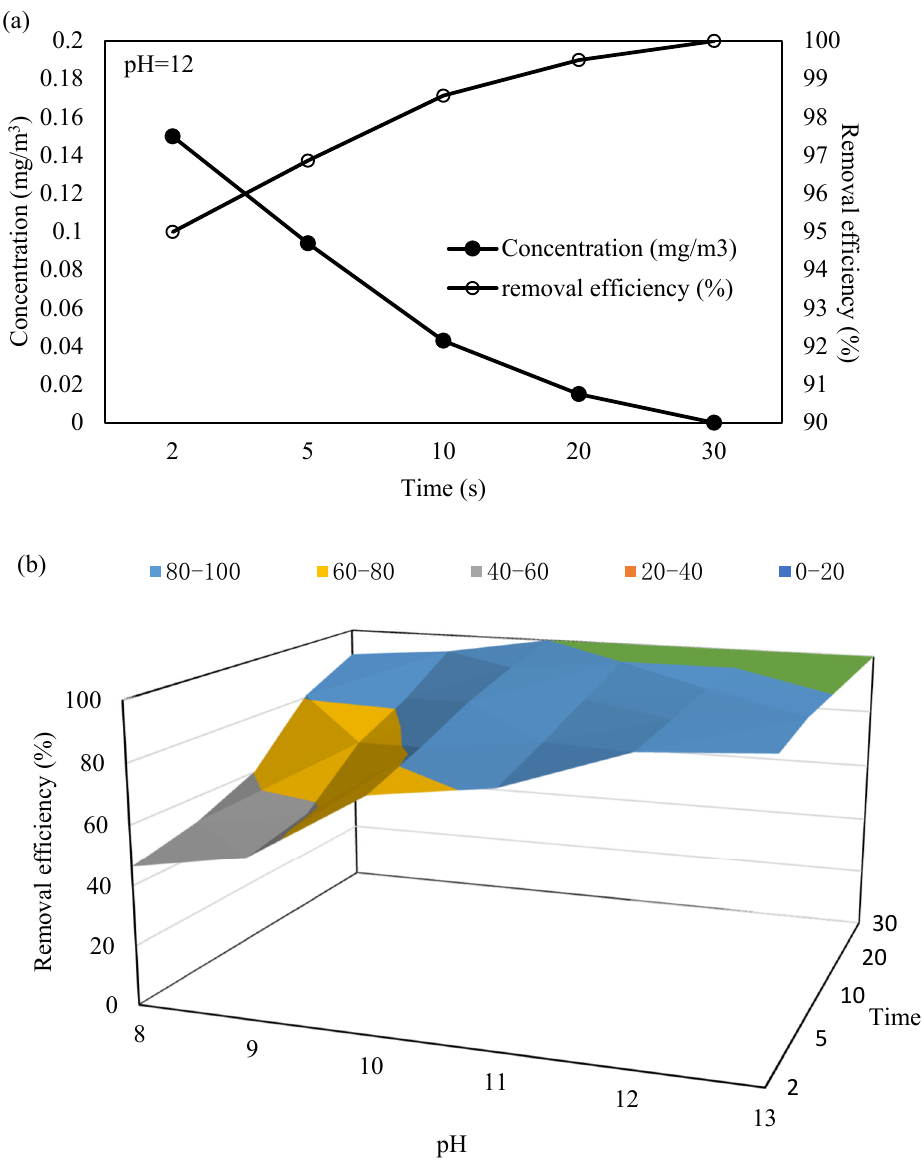
Figure 2. The hydrogen sulfide removal by chemical scrubbing: ( a ) hydrogen sulfide removal at pH 12; ( b ) the hydrogen sulfide removal at different pH and retention time.